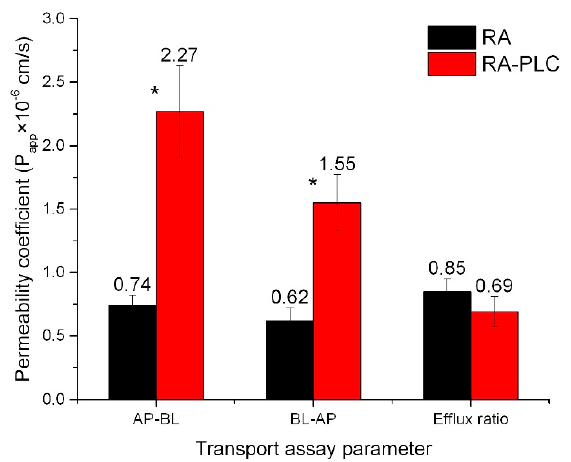
Figure 5. Permeability coefficient of RA and RA-PLC. * p < 0.05 between RA and RA-PLC ( n = 3, mean ± SD).